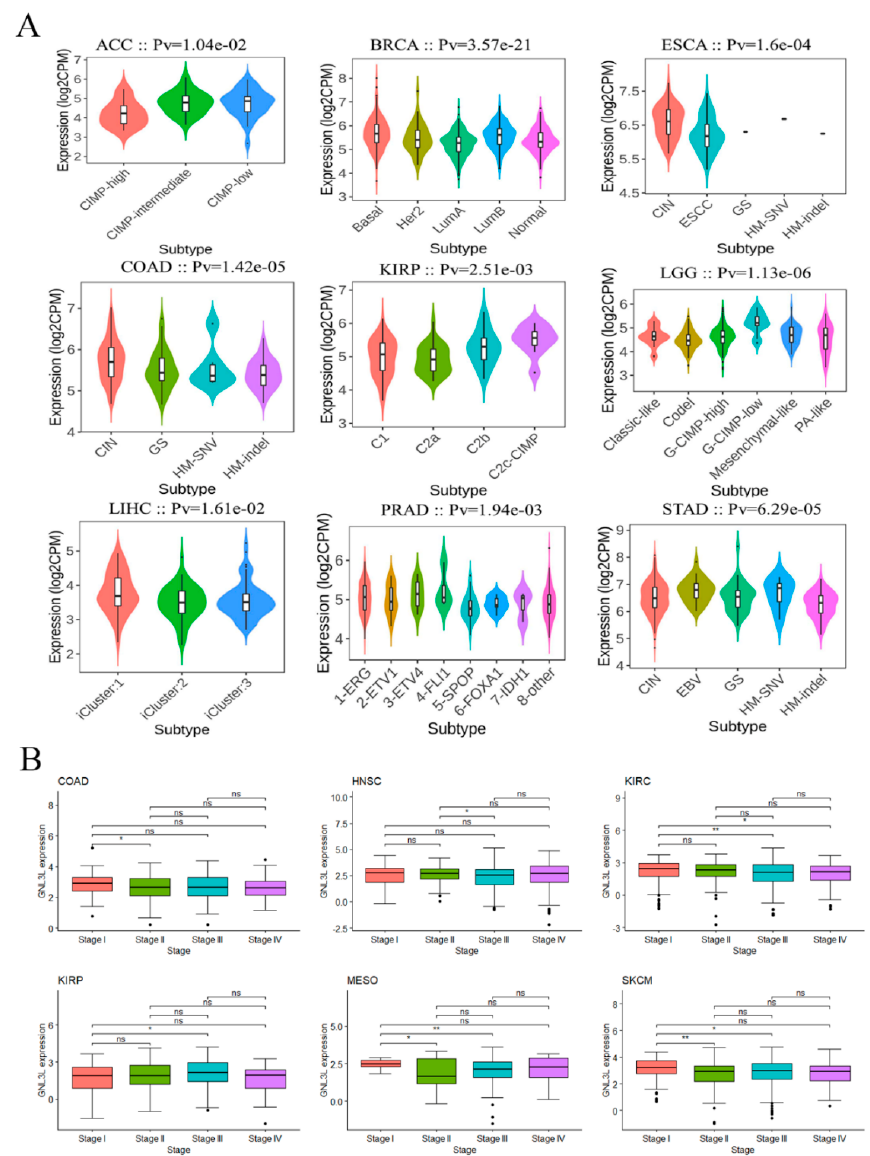
Figure 3. Correlation of GNL3L with cancer molecular subtypes and clinical stages. ( A ) GNL3L expression correlated with molecular subtypes in ACC, BRCA, ESCA, COAD, KIRP, LGG, LIHC, PRAD, and STAD. ( B ) Obvious discrepancy in GNL3L expression in dissimilar clinical stages in COAD, HNSC, KIRC, KIRP, MESO, and SKCM cancers. * p < 0.05; ** p < 0.01.